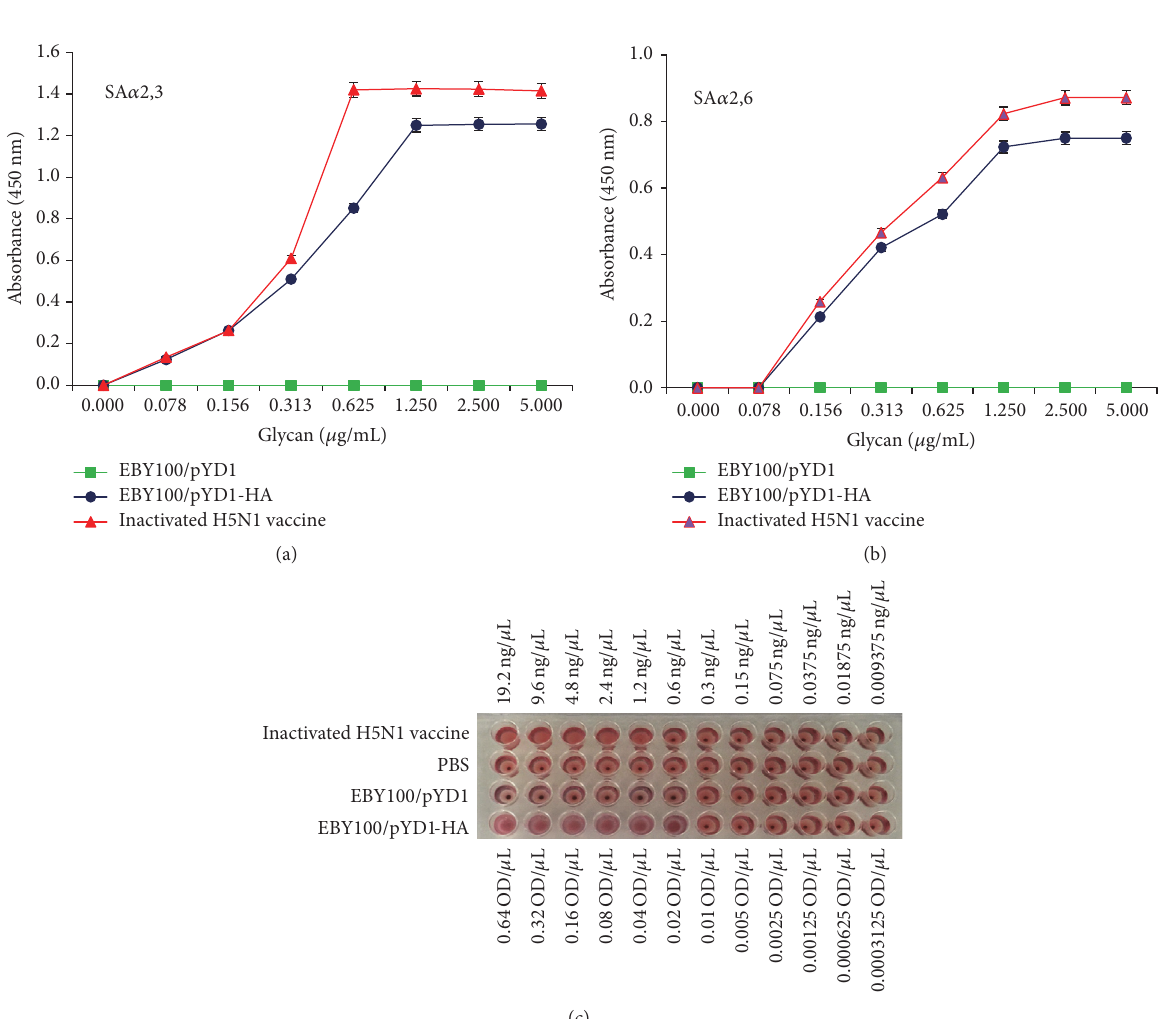
Figure 3: Receptor-binding specificity of yeast surface-displayed HA. Yeast surface-displayed HA binds to (a) 𝛼 2,3-linked sialylglycan receptor (SA 𝛼 2,3) and (b) 𝛼 2,6-linked sialylglycan receptor (SA 𝛼 2,6). EBY100/pYD1 served as a negative control, and an inactivated H5N1 vaccine as a positive control. Error bars represent standard deviations of the mean, which is calculated with three independent repeats. (c) Results of hemagglutination assay. Inactivated H5N1 vaccine served as a positive control, and PBS and EBY100/pYD1 as two negative